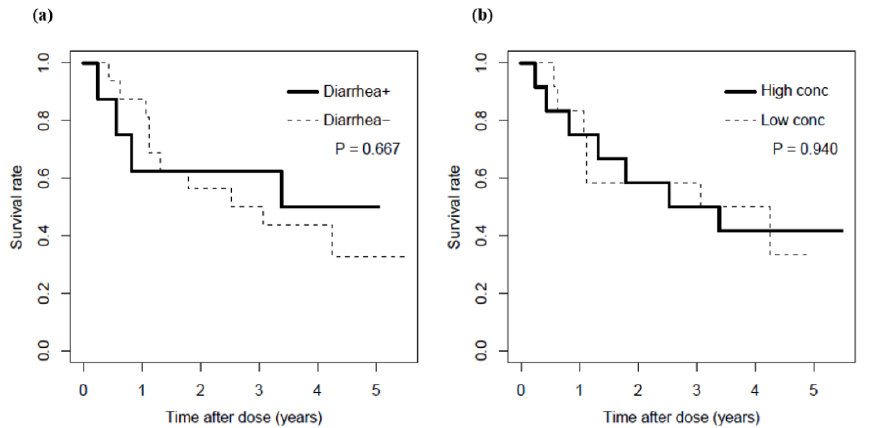
Figure 4. Survival curves in patients with bortezomib therapy. ( a ) Survival curves in the patients with (bold line) or without (dashed line) diarrhea; ( b ) survival curves in patients with higher concentration (>median, bold line) or lower concentration ( ≤ median, dashed line). The median concentration was 0.61 ng/mL.